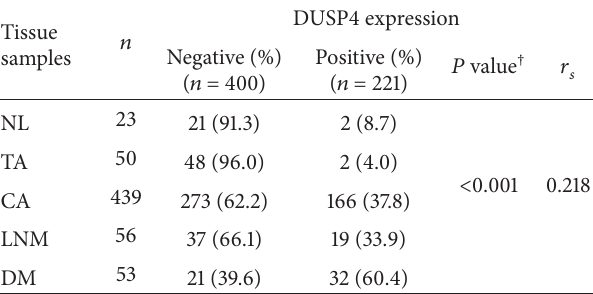
Table 1: DUSP4 expression in NL, TA, CA, LNM, and DM ( 𝑛 = 621).